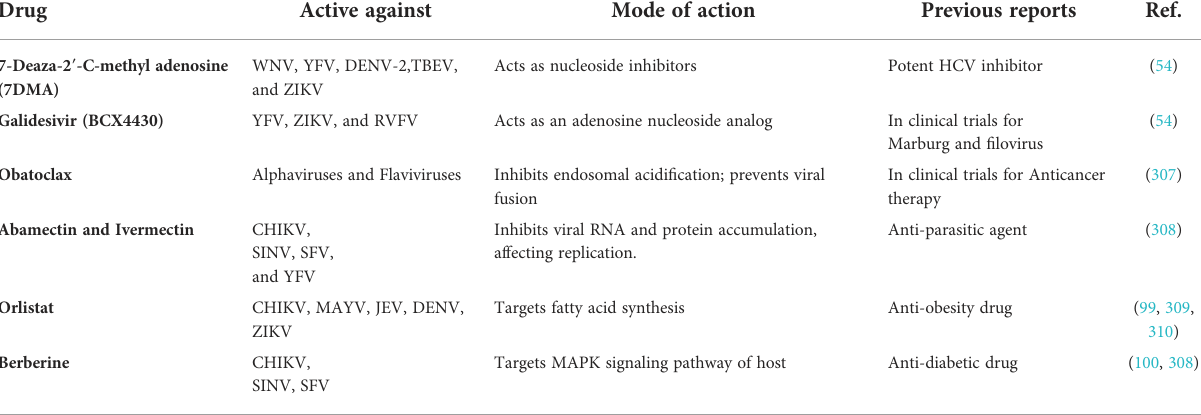
TABLE 9 Broad-spectrum antiviral acting against